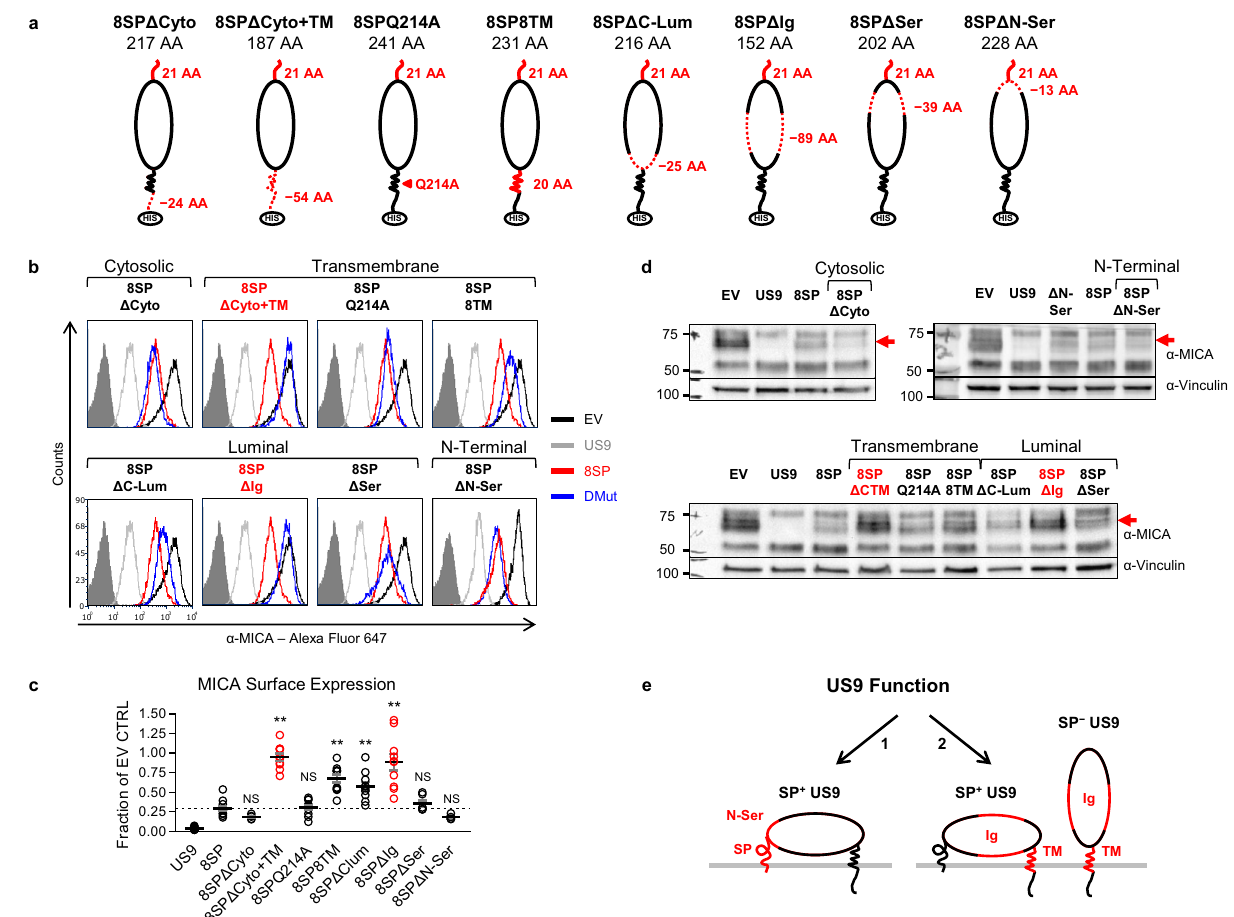
Fig. 5 SP-independent MICA*008 downregulation is mediated by the US9 Ig-like and TM domains. a Schematic representation of US9 double mutants, in which the SP was swapped with the US8 SP and combined with each of the indicated mutations in the following domains: serine-rich area (Ser), Ig- like fold (Ig), other luminal (Lum), transmembrane (TM), and cytosolic (Cyto). Dashed red lines show deleted domains, solid red lines show domains substituted with a homologous US8 sequence, arrow shows a single mutated residue. Mutants were 6XHis tagged (HIS). Mutated sequence length and the total length of each construct without tags are indicated. b Flow cytometry of MICA surface expression in RKO MICA*008-HA cells transduced with an EV (black histograms), US9 (gray histograms), 8SP (red histograms), or the indicated US9 double mutants (blue histograms). Gray- fi lled histograms represent secondary antibody staining of EV cells. Mutants are grouped by mutated region (indicated). Red font highlights complete loss-of-function. Figure combines representative results from separate experiments. c Quanti fi cation of MICA MFIs shown in ( b ), normalized to the EV control. Data show mean ± SEM for at least four independent experiments per mutant. A one-way ANOVA was performed with a signi fi cant effect at the p < 0.05 level for all conditions [F(8,69) = 20.073, p = 2.8 × 10 − 15 ]. A post hoc Dunnett ’ s test was used to compare the MFI for 8SP (dashed line) to that of each mutant. ** p < 0.01, NS non-signi fi cant. d Lysates obtained from the indicated cells were blotted using anti-MICA, anti-His tag, and anti-vinculin as loading control. Different panels show different gels. Mutants are grouped by mutated region (indicated). Red font highlights complete loss-of-function, and the red arrow indicates post-ER MICA*008. Representative of three independent experiments. e Diagram of the two distinct mechanisms of US9-mediated MICA*008 degradation: (1) US9 SP-dependent mechanism, present only in the SP + isoform, requires the SP and the cleavage-delaying N-Ser domain; and (2) US9 SP- independent mechanism, present in both SP + and SP − isoforms, requires the Ig-like and TM domains. See also Fig. S5, Table 1, and the Source data fi le for experimental data and full